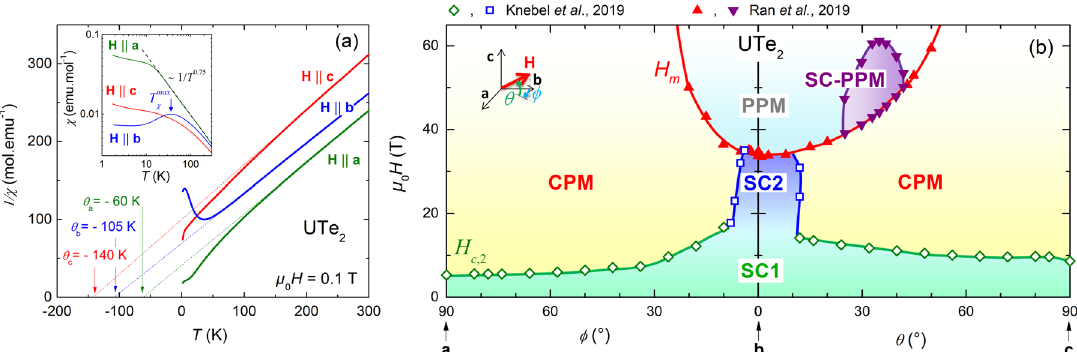
Fig. 1 Magnetic susceptibility and phase diagram of UTe 2 . a Temperature-dependence of the inversed magnetic susceptibility 1/ χ of UTe 2 in magnetic fi elds H applied along the three main crystallographic directions a , b , and c . Inset: Temperature-dependence of the magnetic susceptibility χ for H || a , b , and c , in a log-log scale. b Low-temperature magnetic- fi eld versus angle phase diagram of UTe 2 , in fi elds applied along variable directions from b to a (angle ϕ ) and from b to c (angle θ ). Two low-temperature paramagnetic regimes and identi fi ed: correlated paramagnetism (CPM) and polarized paramagnetism (PPM). SC1 is the low- fi eld superconducting phase, and SC2 and SC-PPM are the superconducting phases induced by magnetic fi elds H || b and H tilted by 27 ± 5° from b in the ( b , c ) plane, respectively. H c ,2 is the critical superconducting fi eld and H m is the metamagnetic fi eld. Data from by Ran et al. 33 and Knebel et al. 37 were plotted in this